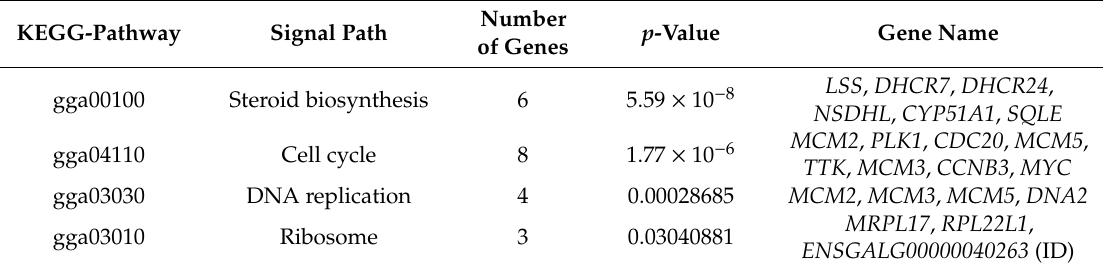
Table 10. The significantly enriched pathway for the four-week-old males.